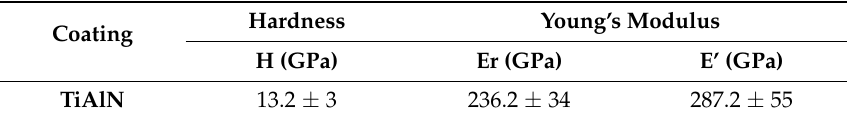
Table 3. Ultra-microhardness and Young’s modulus of the TiAlN film.